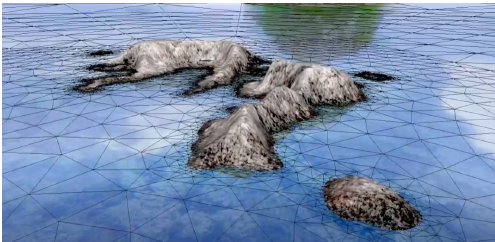
Figure 3. Schematic diagram of the sampling point distribution in space for phase interpolation.